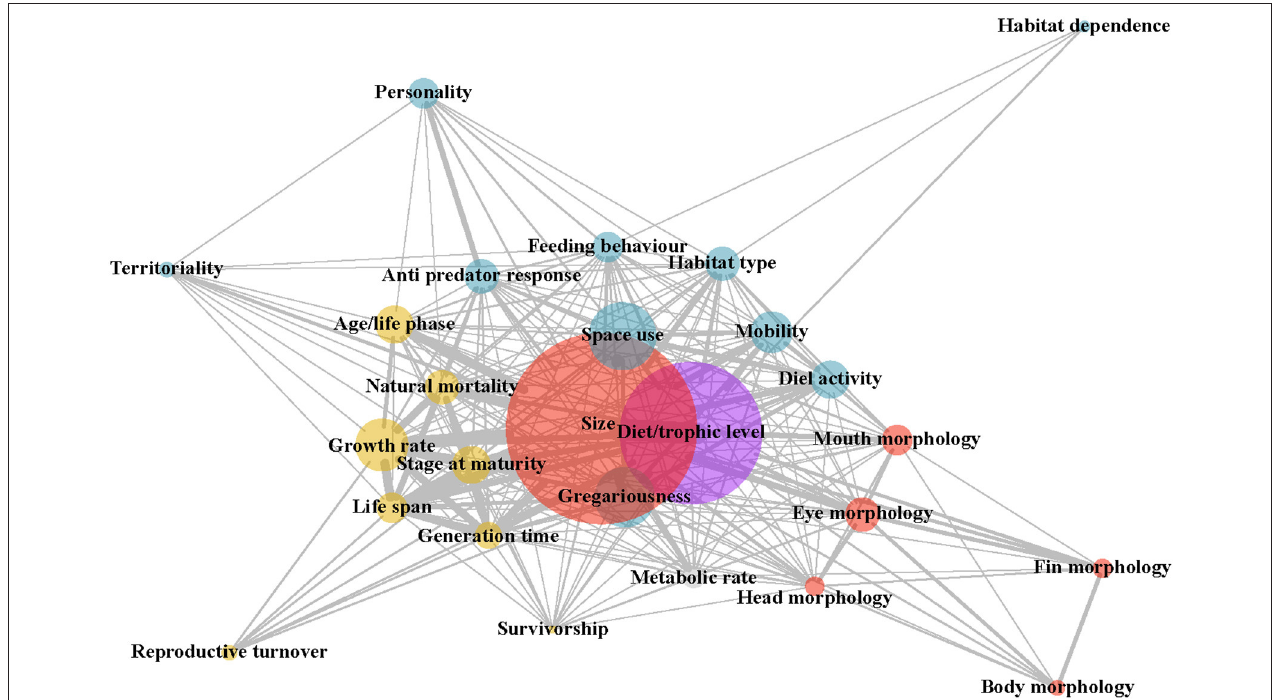
FIGURE 2 | Network diagram showing the use of traits together within papers. Each node corresponds to a trait, with its size representing the number of papers using that trait. The color of trait nodes corresponds to broad trait groupings (blue: behavioral, yellow: life-history, red: morphological, gray: physiological, purple: diet). The thickness of the edges (i.e., lines) illustrates the number of papers in which two traits being connected were used together. The spatial position of the node indicates which traits it is most often used in conjunction with, where the more central nodes represent traits used frequently with all other traits. Rankings of centrality scores (median of degree centrality, subgraph centrality, and topological coefficient) showed size to be the most central trait, diet and gregariousness as the second most central traits, and habitat type and feeding behavior as the third most central traits (see Supplementary Figure 4